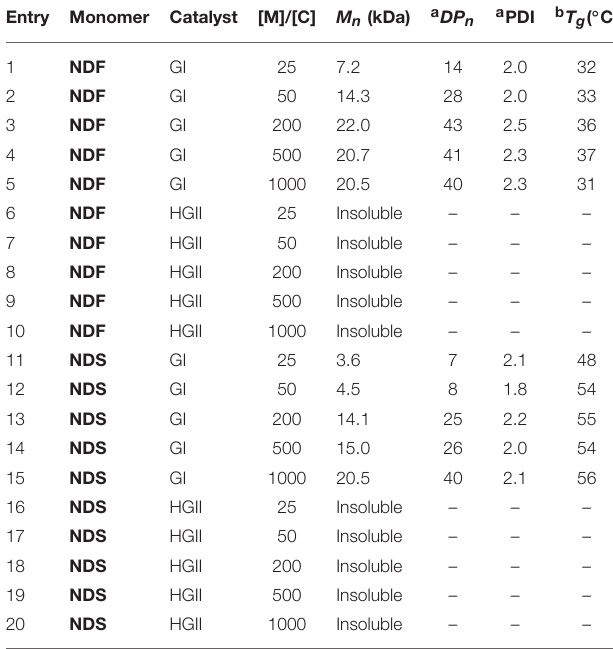
Table 1 , according to: n tot = n DPPH /2 ∗ EC 50 [ n DPPH : initial DPPH mole number (nmol)].